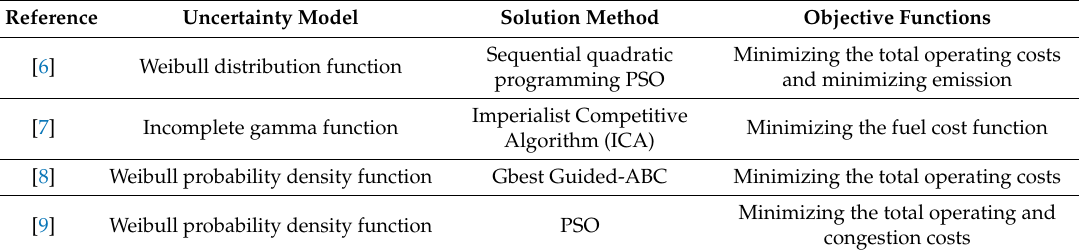
Table 1. Di ff erent methods to model the random behavior of wind power